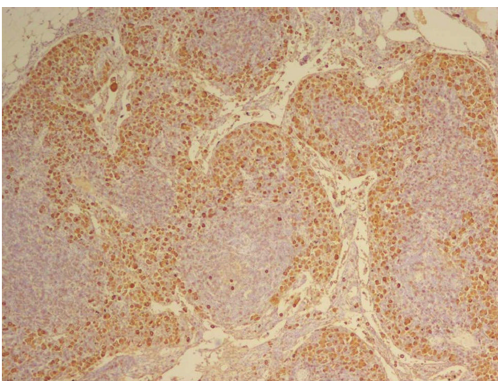
Figure 1: Primary lobular carcinoma.